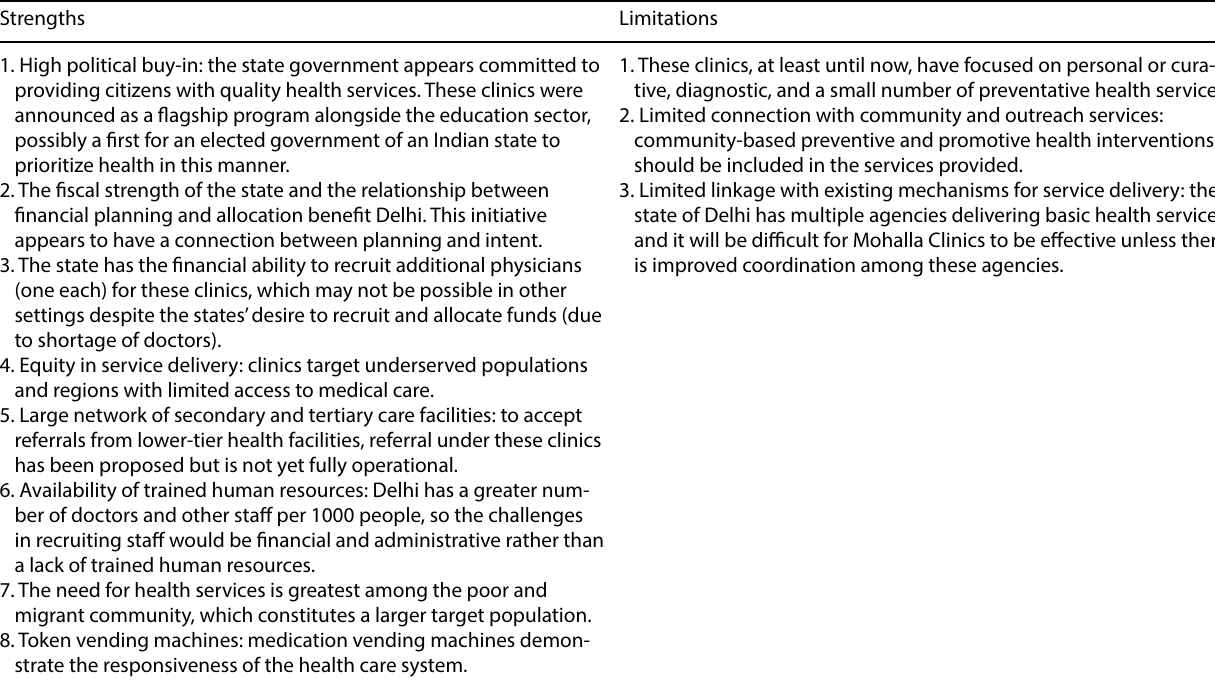
Table 3 Mohalla Clinics concept: Strengths and Limitations